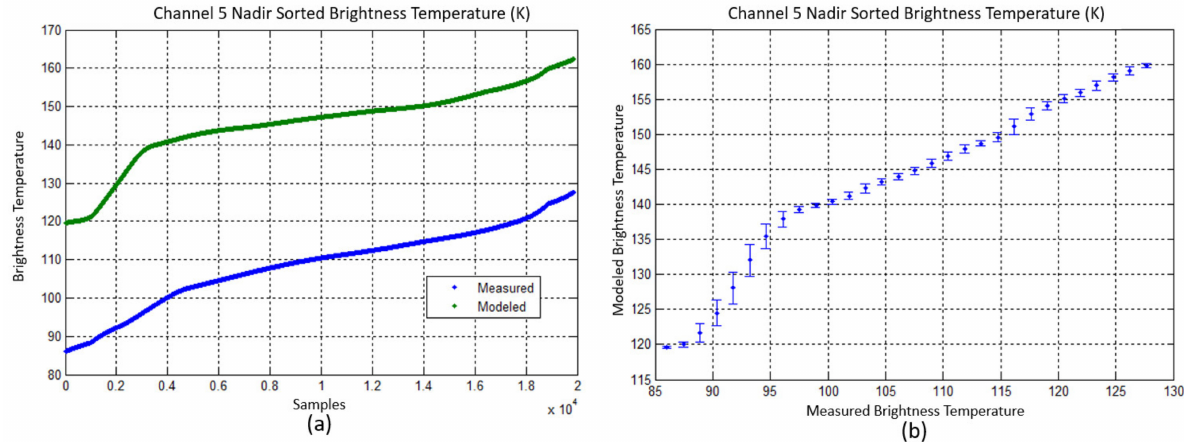
Figure 9. HIRAD T A and T a antenna brightness temperature comparison after sorting, where ( a ) is the sorted along-track samples of the measured and modeled, ( b ) are the points stored in the look-up table, where the blue dots in ( b ) are sample data points (less than 100 bins for depiction only) and error bars are ± 1 standard deviation from the